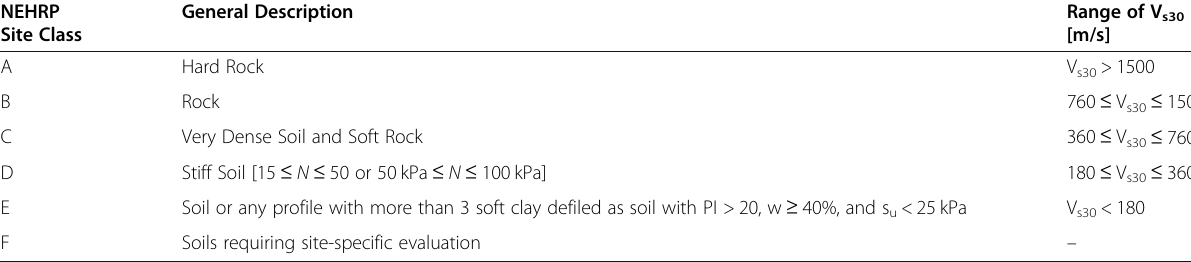
Table 2 Site classification based on V s30 (National Earthquake Hazard Reduction Provision,